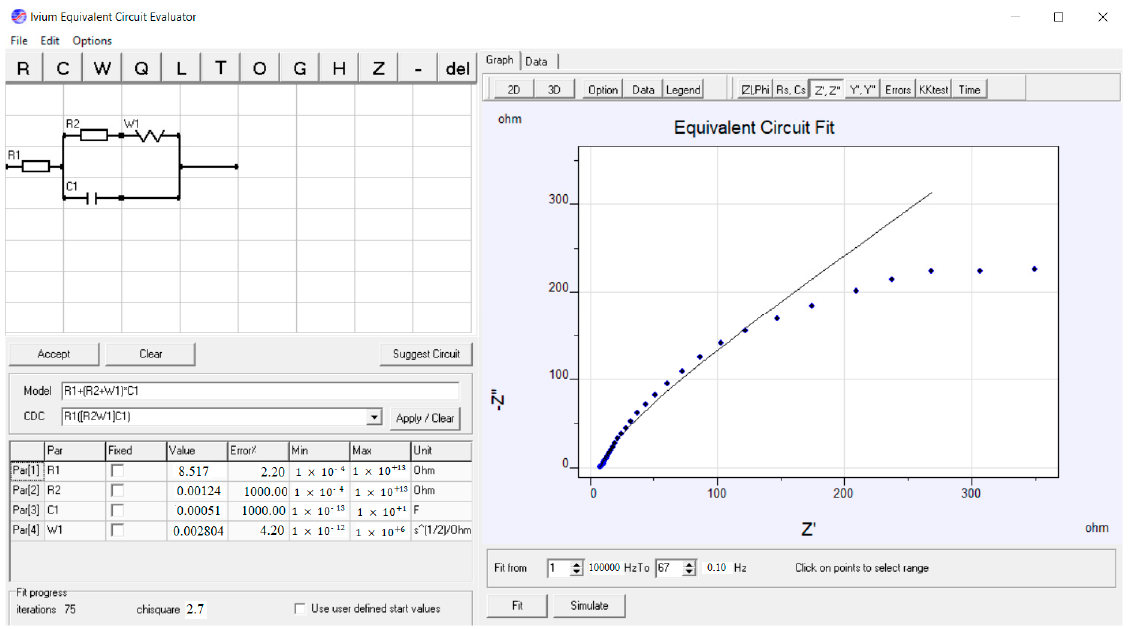
Figure 11. EC of fitted EIS data of Pt/S-ZrO 2 -GNPs in 0.5 M 𝐻 (cid:2870) 𝑆𝑂 (cid:2872) + 1 M 𝐶𝐻 (cid:2871) 𝐶𝐻 (cid:2870) 𝑂𝐻 solution.